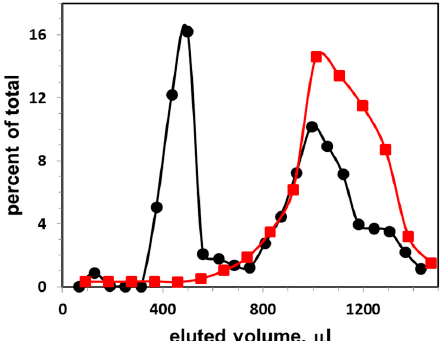
Figure 1. Gel filtration elution profile of exosomes (at concentration 6 × 10 9 particles per mL) isolated from FBS, and next incubated with CTB555: vertical axis, percent of total fluorescence; horizontal axis, eluted volume. The excitation and emission wavelengths of the fluorescence were λ ex / λ em = 545 / 565 nm. Black circles, distribution of CTB555 between exosomes and bu ff er; red squares, distribution of CTB555 when eluted without exosomes.